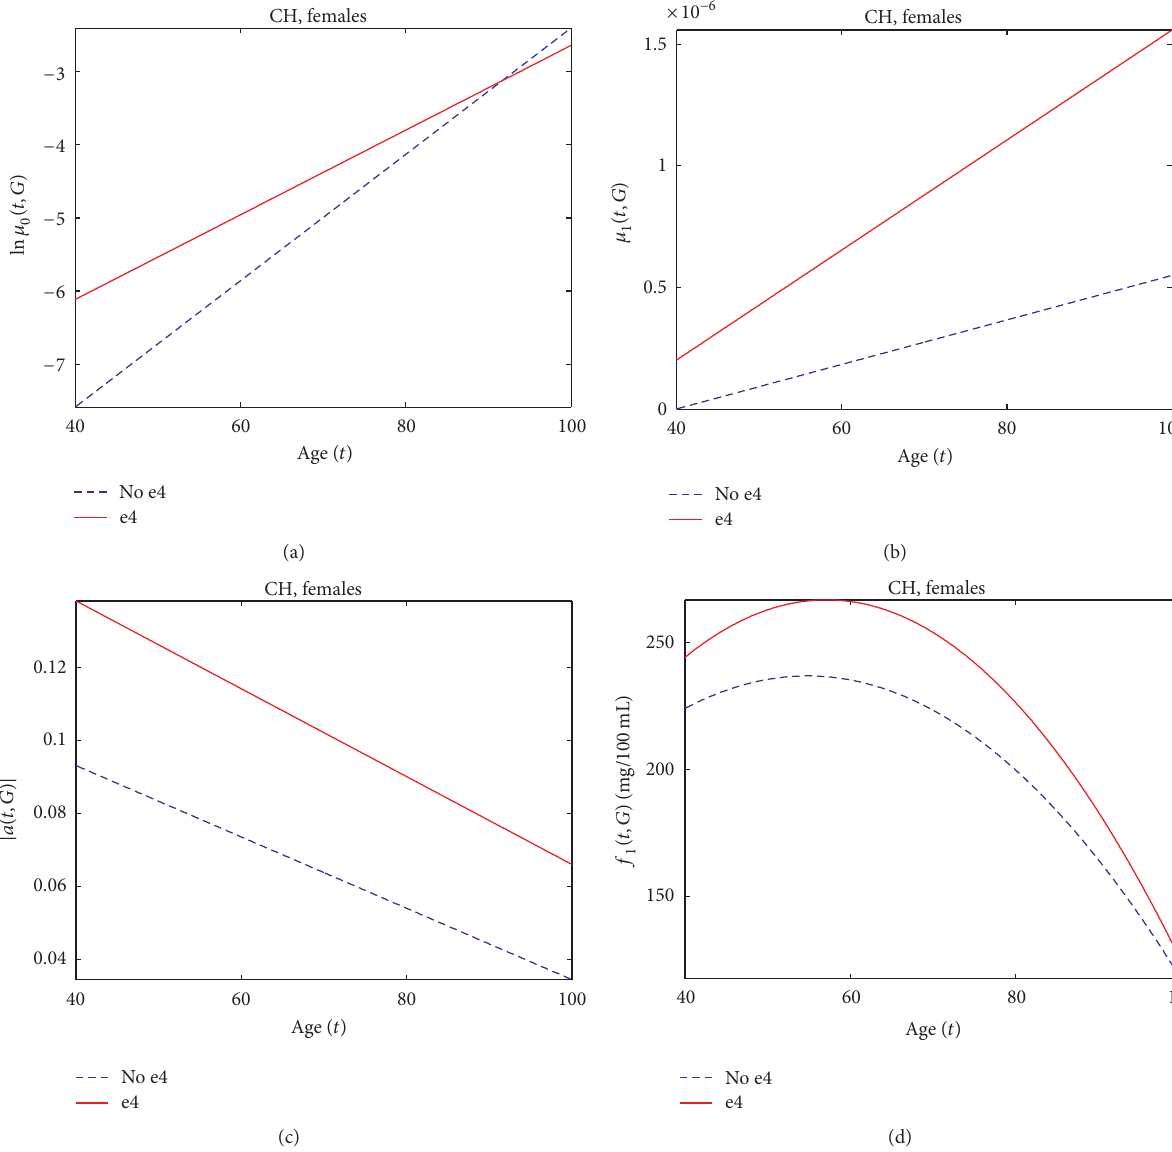
F 4: Application of the genetic stochastic process model to longitudinal measurements of total cholesterol (“CH”) and data on mortality for females in the Framingham Heart Study (original cohort). Estimates of the logarithm of the baseline hazard (a), the multiplier in the quadratic part of the hazard (b), the adaptive capacity (the absolute value of the feedback coefficient) (c), and the mean allostatic trajectory (d) for carriers (“e4”) and noncarriers (“No e4”) of the APOE e4